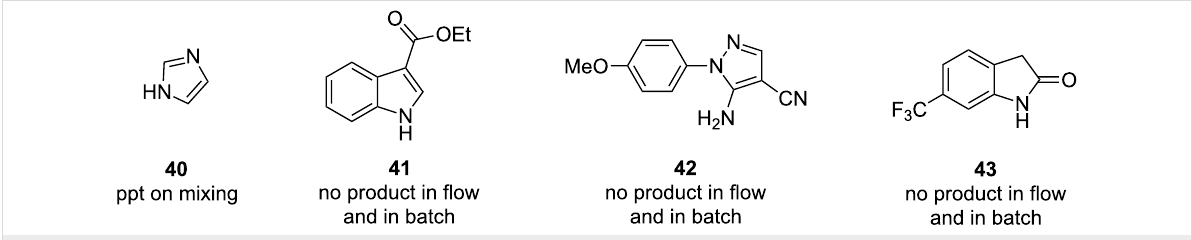
Figure 7: Substrates that gave no products in flow.